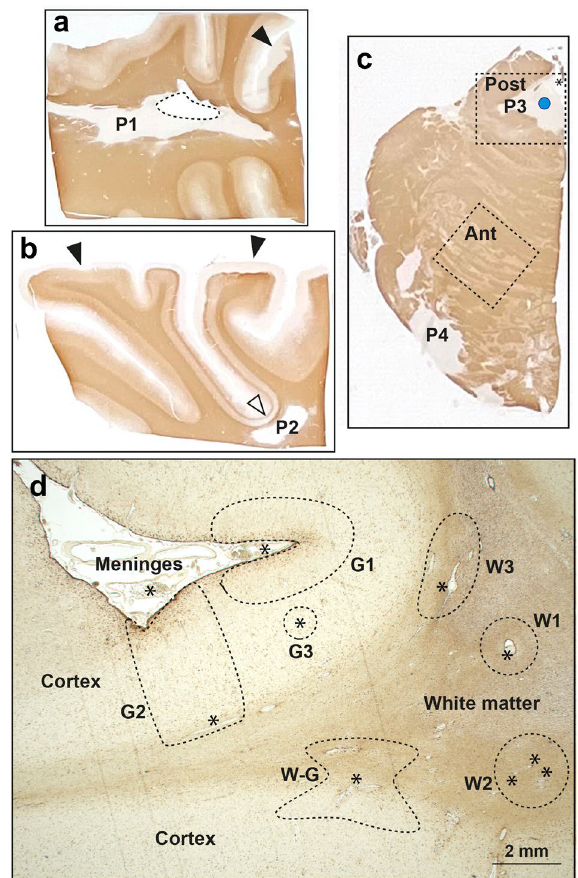
Figure 1. Sites of demyelination in MS (MBP stains myelin brown). ( a ) An MS plaque (P1) in the deep white matter surrounds the lateral ventricle (dashed outline). Subpial cortical demyelination is present in some gyri (arrowhead). MBP/H. MS09. ( b ) A subcortical white matter MS plaque (P2) is accompanied by cortical demyelination in the adjacent cortex at the base of the sulcus (open arrowhead). Widespread subpial cortical demyelination is present (closed arrowheads). MBP/H. MS09. ( c ) In this hemi-pons, one plaque is seen (P3) next to the fourth ventricle (*) and another with a broad base (P4) faces the meninges. The site of the locus ceruleus is shown by the blue dot. Typical sampling areas for LA-ICP-MSI are shown by the dashed boxes: posterior (Post) to include the locus ceruleus, and anterior (Ant) to include pale grey matter and more darkly staining white matter. MBP/H. MS09. ( d ) Asterisks indicate small blood vessels in the frontal lobe as centres for demyelination in either: W1 deep white matter from a single blood vessel; W2 deep white matter from multiple small blood vessels; W3 subcortical white matter from subcortical blood vessels; W-G leukocortical, from junctional white and grey matter blood vessels; G1 subpial, from leptomeningeal/subpial cortex blood vessels; G2 complete cortical, from combined leptomeningeal and grey/white junctional blood vessels; G3 intracortical from small blood vessels only seen microscopically. AMG/GFAP/H.